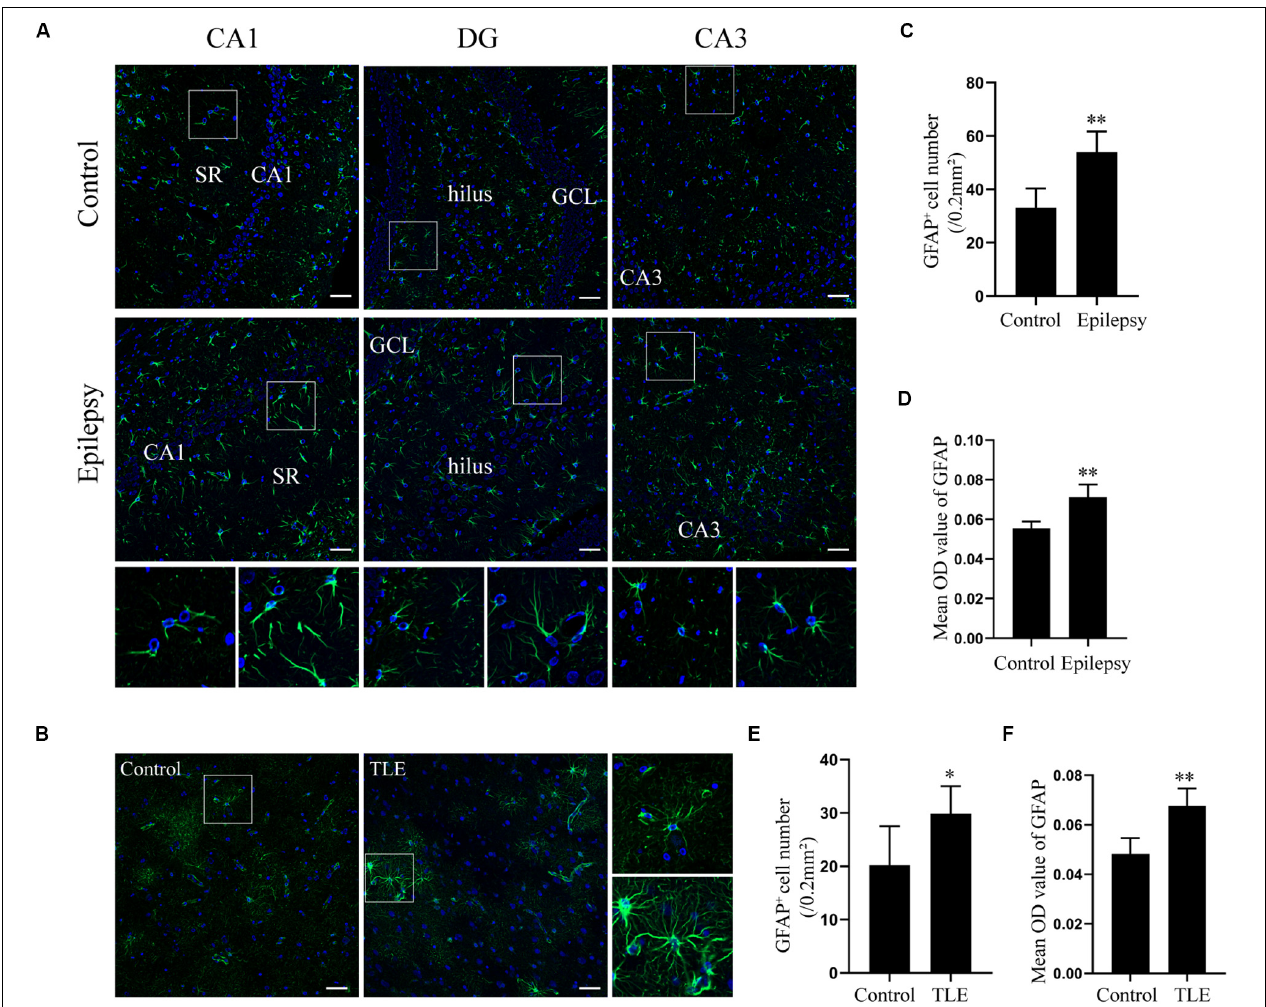
FIGURE 2 | Astrocyte activation in the hippocampal section of pilocarpine-induced epileptic rats at day 7 after SE and the temporal cortex specimens of drug-resistant TLE patients. (A) Immunofluorescence staining showed the activation of astrocyte in the epileptic rat hippocampus. SR, stratum radiatum; GCL, dentate granule cell layer. Scale bar = 50 µ m. (B) Immunofluorescence staining demonstrated the activation of astrocyte in the TLE patient temporal cortex. Scale bar = 50 µ m. (C) GFAP positive cell number in rat hippocampus. (D) Quantitative analysis of the mean OD value of GFAP positive cells in rat hippocampus. (E) GFAP positive cell number in the patient temporal cortex. (F) Quantitative analysis of the mean OD value of GFAP-positive cells in the patient temporal cortex. Data are presented as mean ± SD ( n = 4). Student’s t -test, ∗ P < 0.05, ∗∗ P < 0.01, versus the control